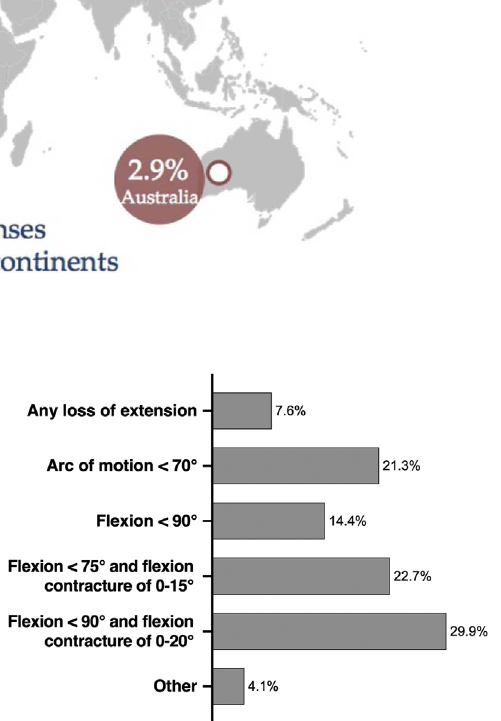
Figure 2. Results of the survey question: How many years have you been in independent practice?